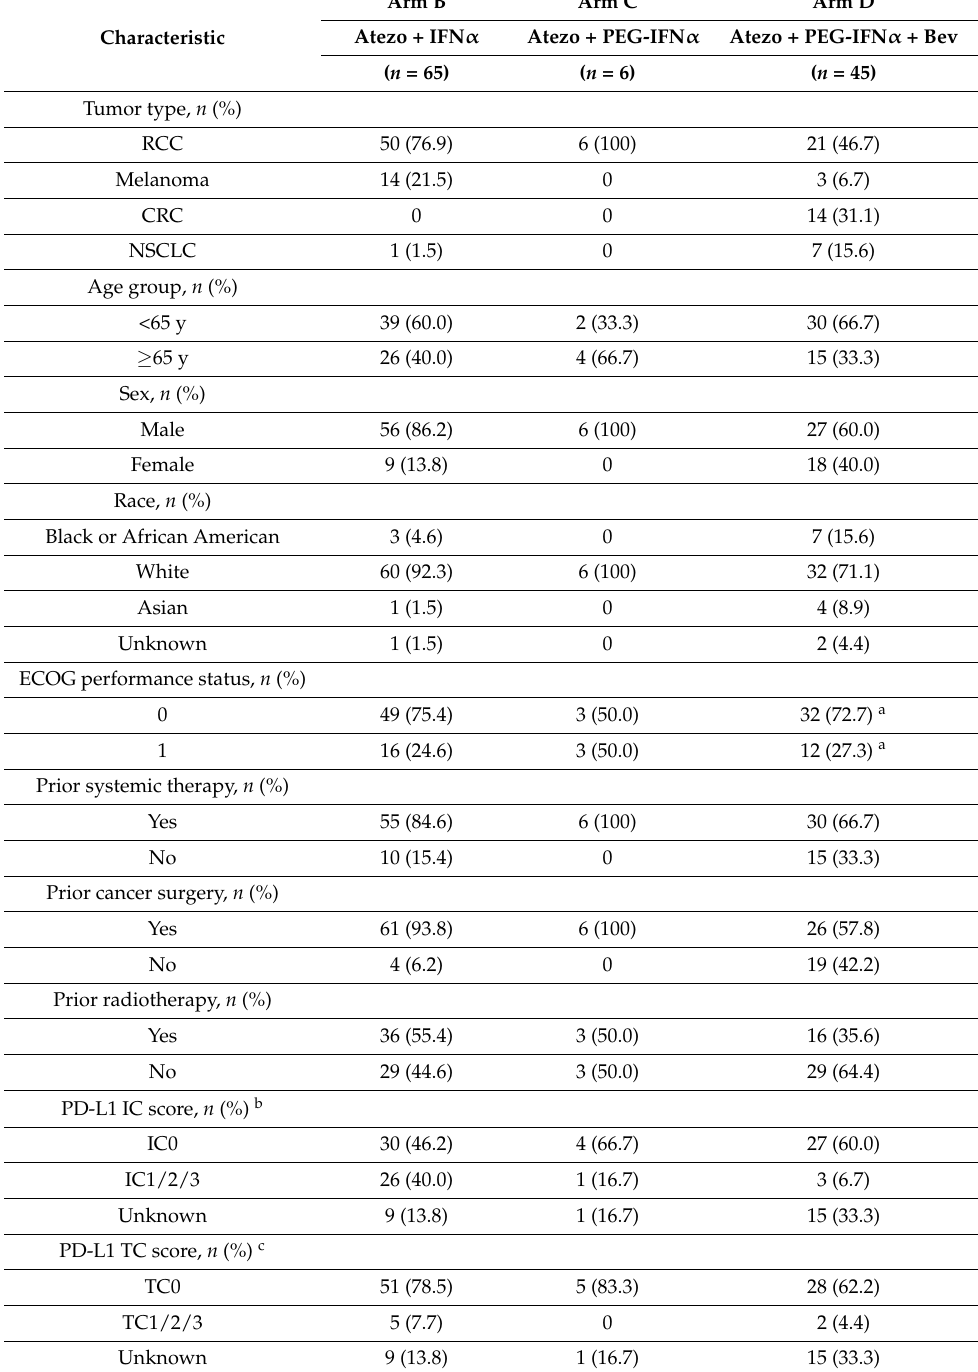
Table 1. Baseline demographic and patient